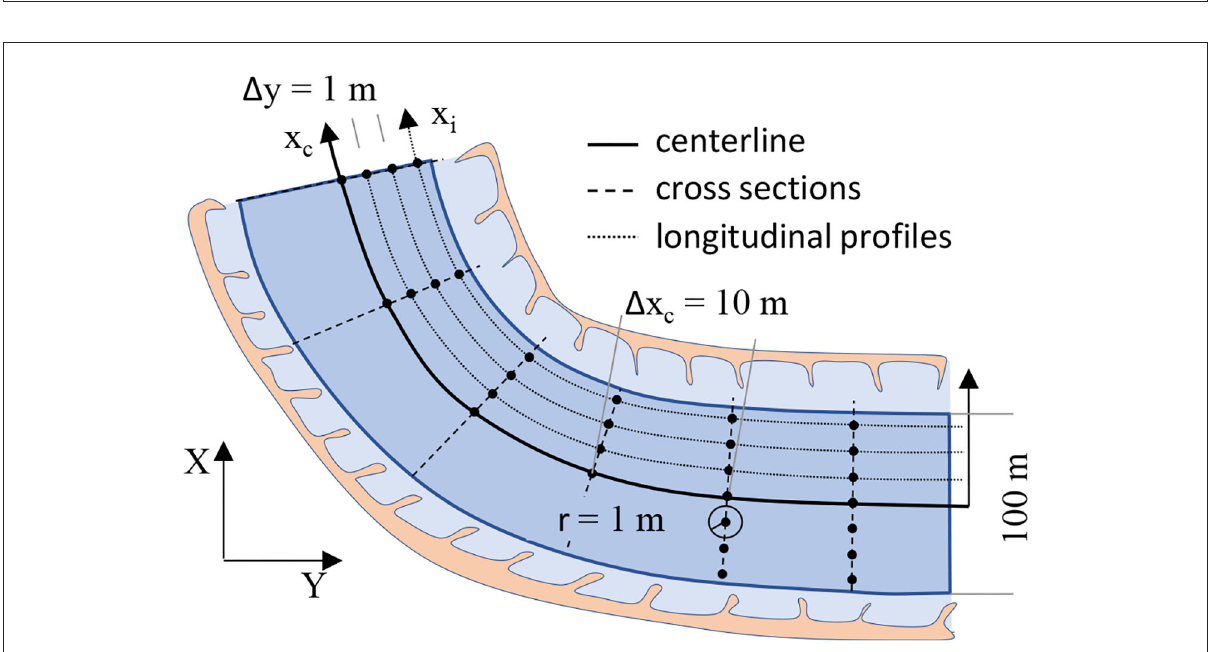
FIGURE4 Sketch of the curvilinear coordinate system used for the further